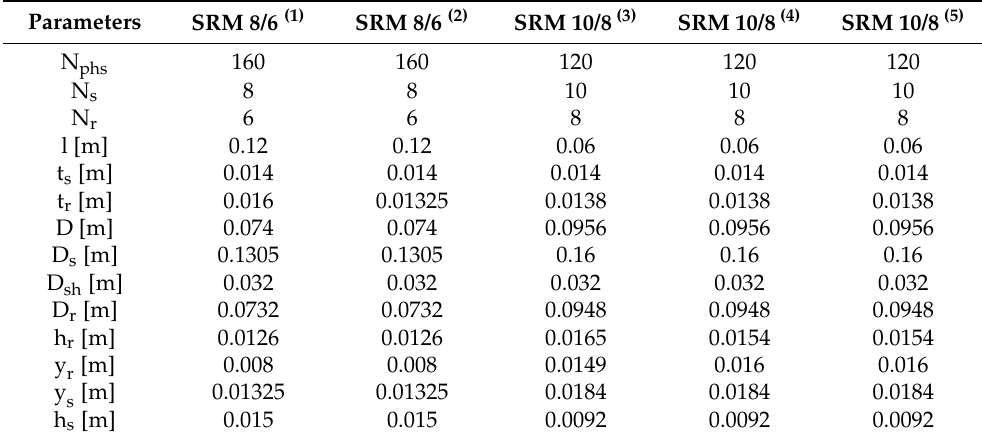
Table 1. Construction parameters of tested motors.